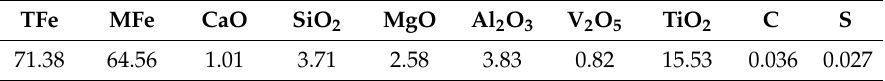
Table 1. Chemical compositions of metallized pellet (wt.